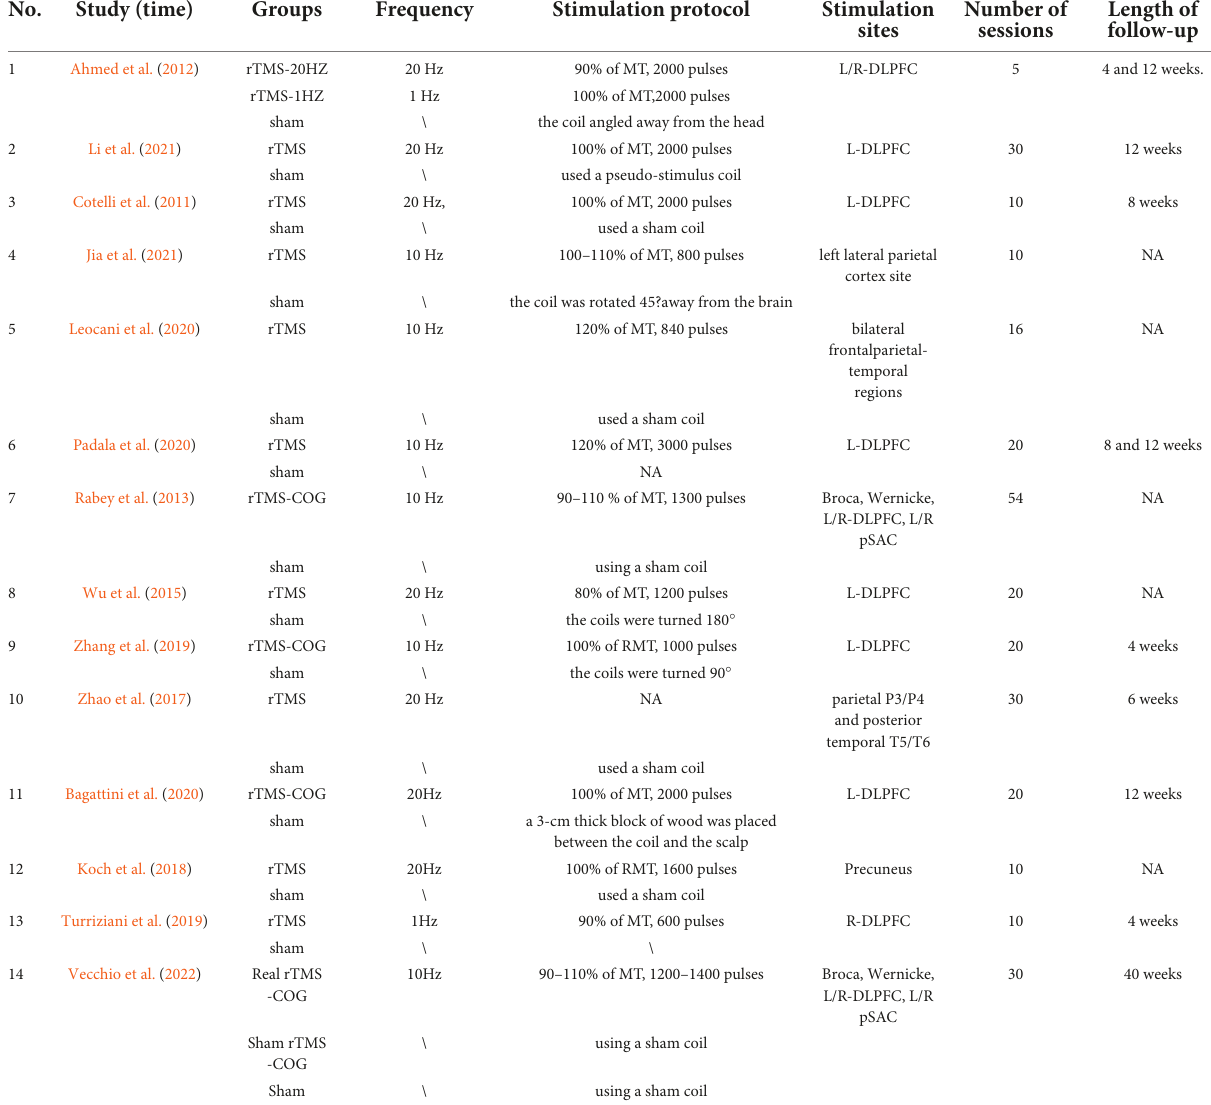
TABLE 2 Description of repetitive transcranial magnetic stimulation (rTMS) intervention in the included studies.